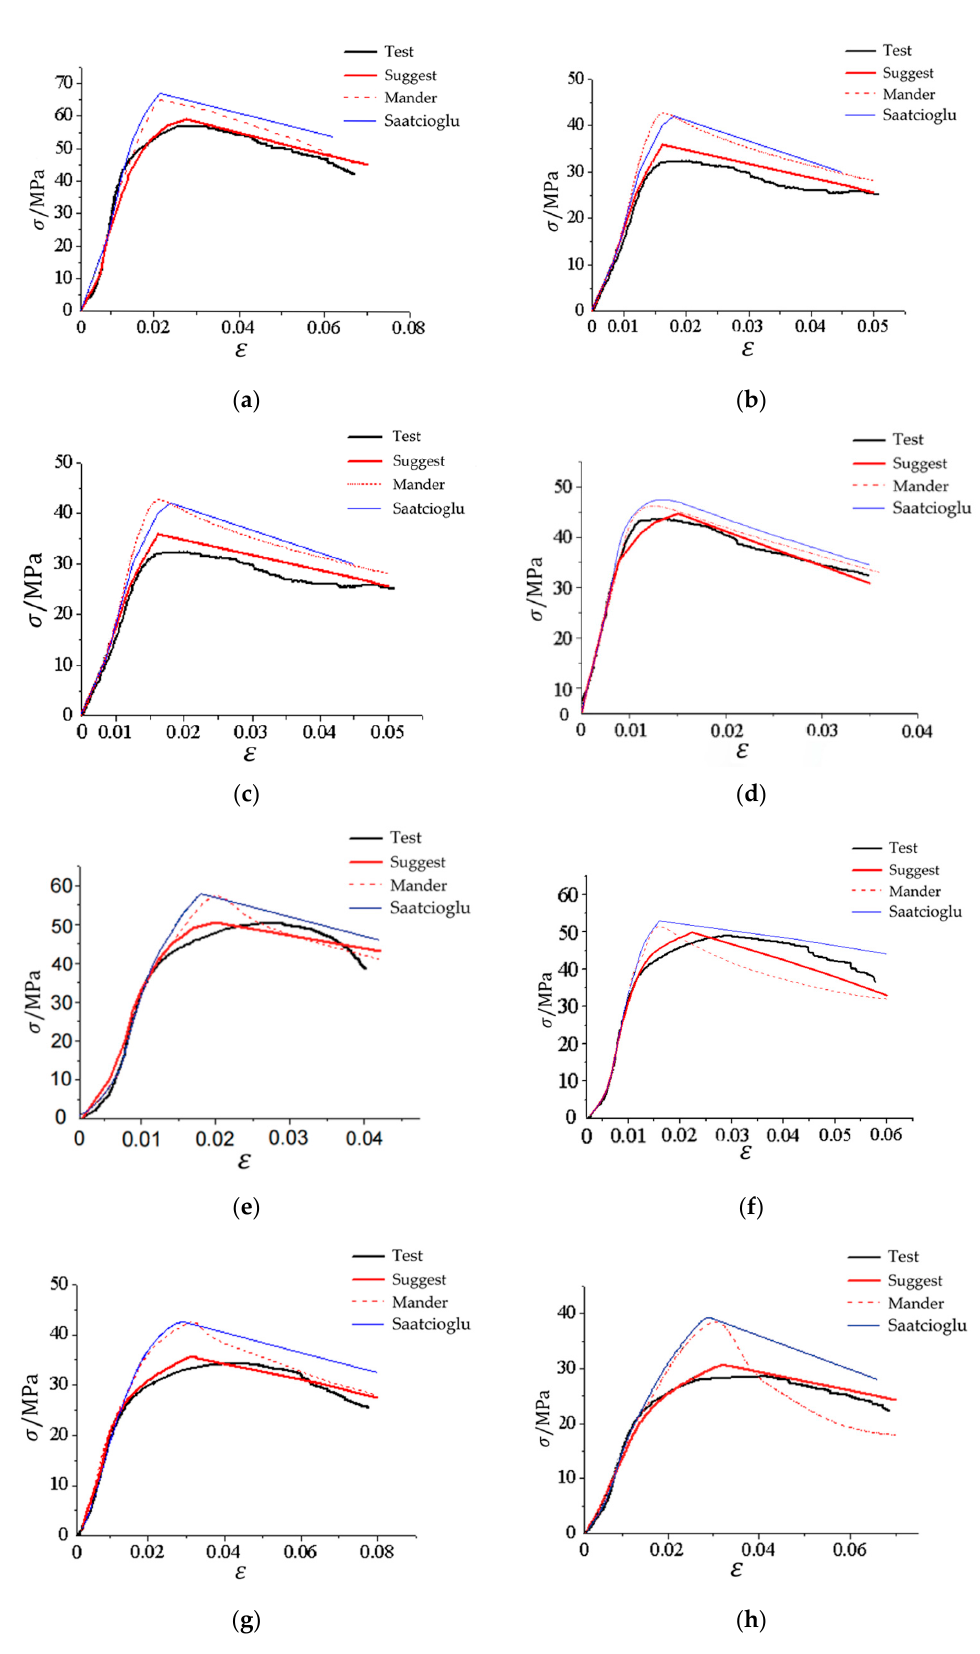
Figure 11. Comparison of stress-strain curves of specimens. ( a ) Specimen A-1; ( b ) Specimen A-2; ( c ) Specimen A-3; ( d ) Specimen A-4; ( e ) Specimen A-5; ( f ) Specimen B-1; ( g ) Specimen B-2; ( h ) Specimen